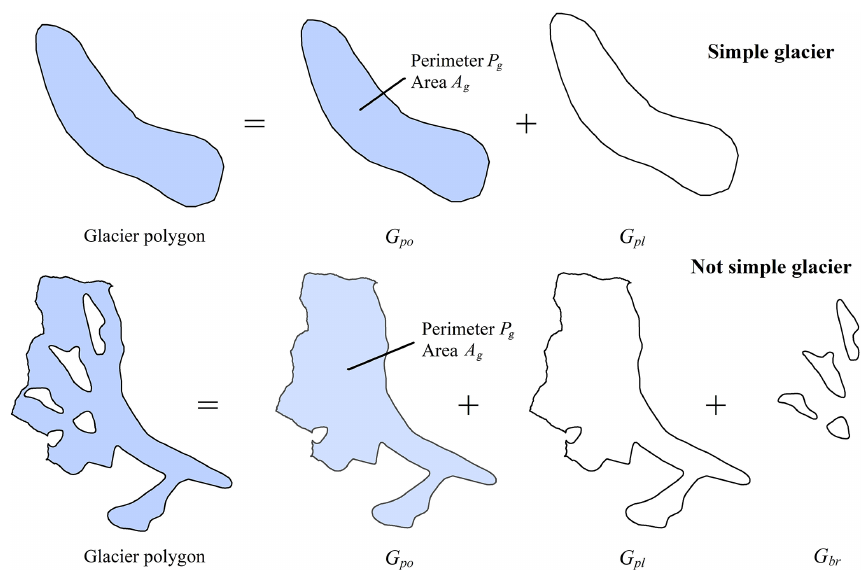
Figure 3. The schematic of processing raw data ( G po denotes the polygon of the glacier, G pl denotes the polyline of the glacier’s outer boundary and G br denotes the boundary of the bare rock in the glacier).